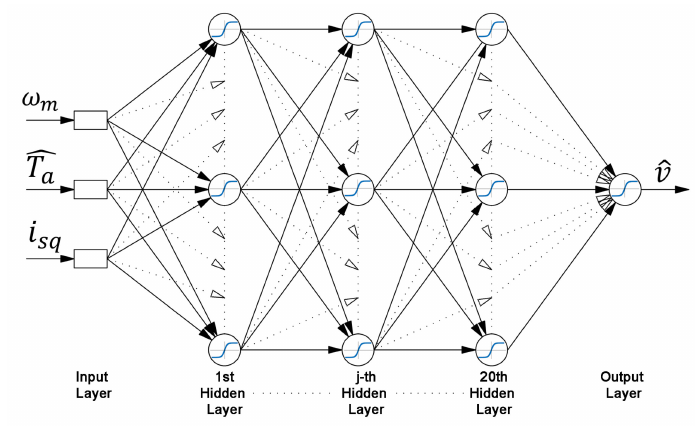
Figure 8. Shallow NN with twenty hidden